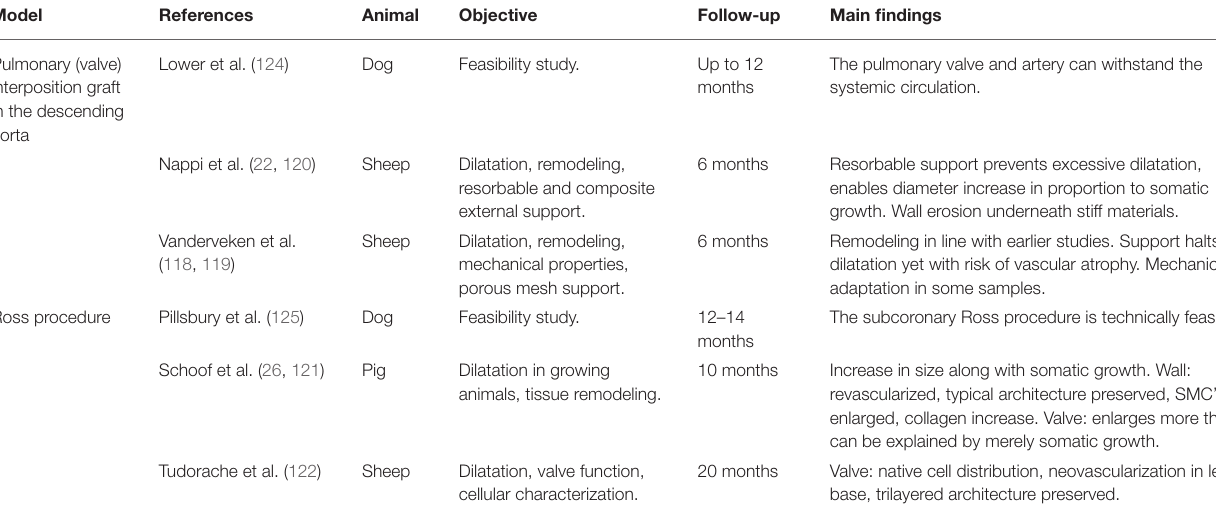
TABLE 2 | Overview of animal models relevant to the Ross procedure with main findings (22, 26, 84,